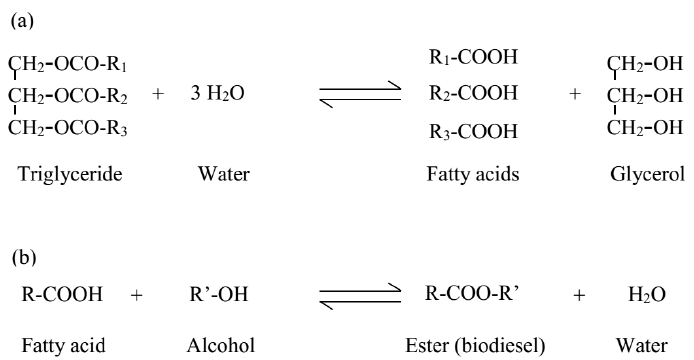
Figure 2. Mechanism of the “hydro-esterification-route”: ( a ) hydrolysis of triglyceride to produce FFA and glycerol; and ( b ) esterification of FFA and alcohol to produce ester and water.